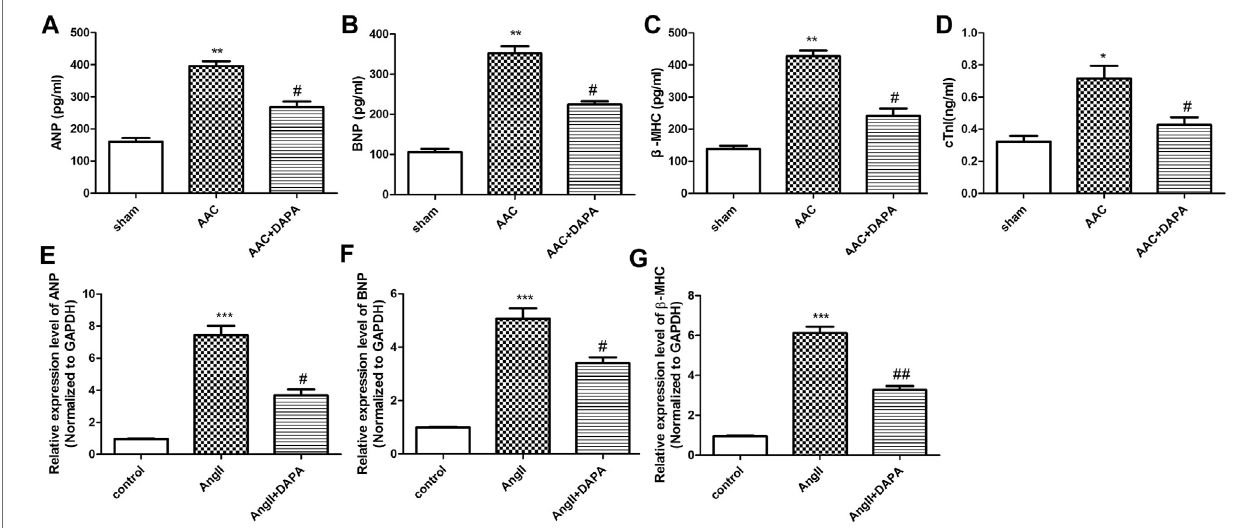
FIGURE 2 | Effect of dapagli fl ozin on the level of cardiac hypertrophy-related genes in AAC-induced mice. The contents of ANP (A) , BNP (B) , β -MHC (C) and cTnI (D) incardiactissuesofdifferentgroupsweredetectedviaELISAkits.qRT-PCRanalysiswasperformedtodetectthemRNAexpressionofANP (E) ,BNP (F) and β -MHC (G) . The data were expressed as mean ± SD, * p < 0.05, vs. sham group; # p < 0.05, vs. AAC